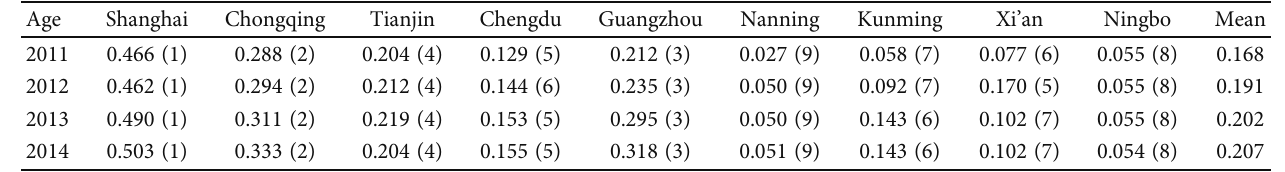
Table 5: Logistics capacity value of core cities along “ the Belt and Road ” .